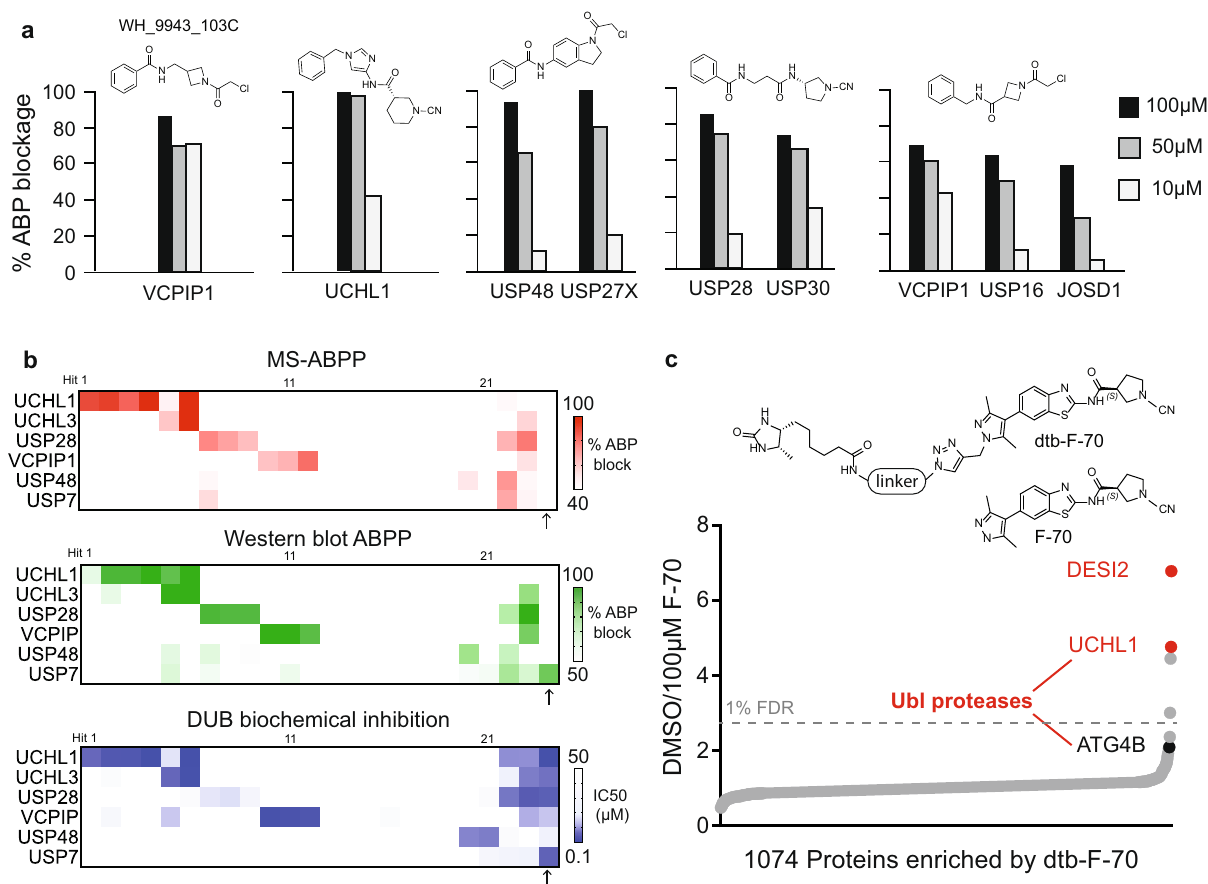
Fig.4|Hitvalidation.a Selectedhitswerecon fi rmedbydose – responseDUB-ABPP over 100, 50, 10 µ M. b Overall, we observed high con fi rmation rates and excellent agreement for assays spanning compound binding in mass spectrometry (red), westernblot(green),andenzymeinhibition(blue)forlibraryhitstargetingUCHL1, UCHL3, USP7, USP28, USP48 and VCPIP1. An outlier (XL-9872-111B) for which we observed poor agreement across assay types is shown on the rightmost column. Data for each DUBisshown ina row (6DUBstotal) and data for each compound is